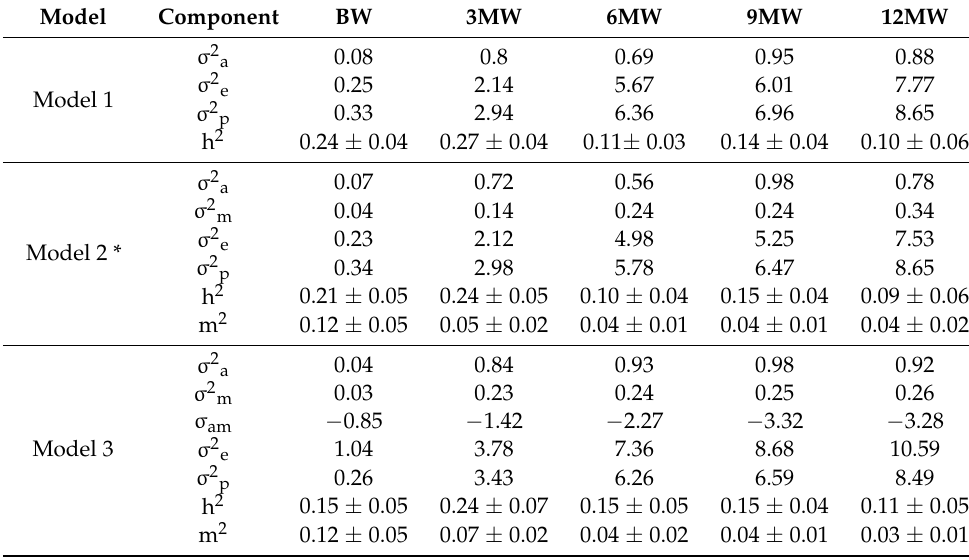
Table 3. (Co)variance components and heritability estimates of body-weight traits.